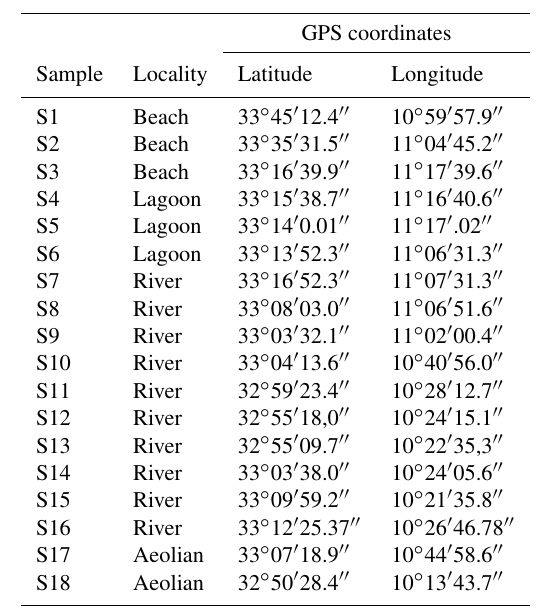
Table 1. Geographic location and GPS coordinate of the studied samples.